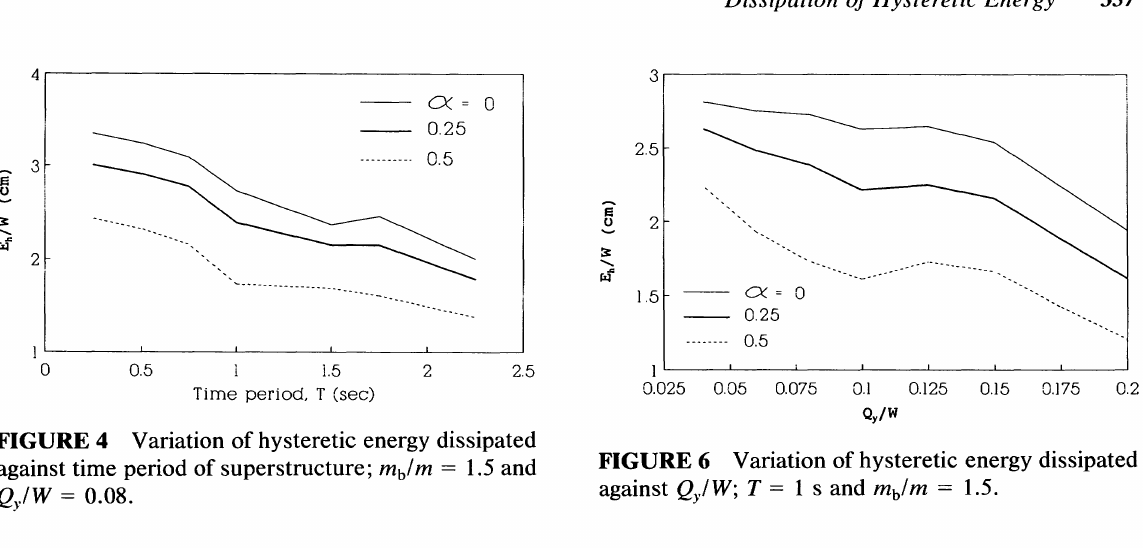
FIGURE 6 Variation of hysteretic energy dissipated against Q/W; T = I sand mb1m = 1.5.